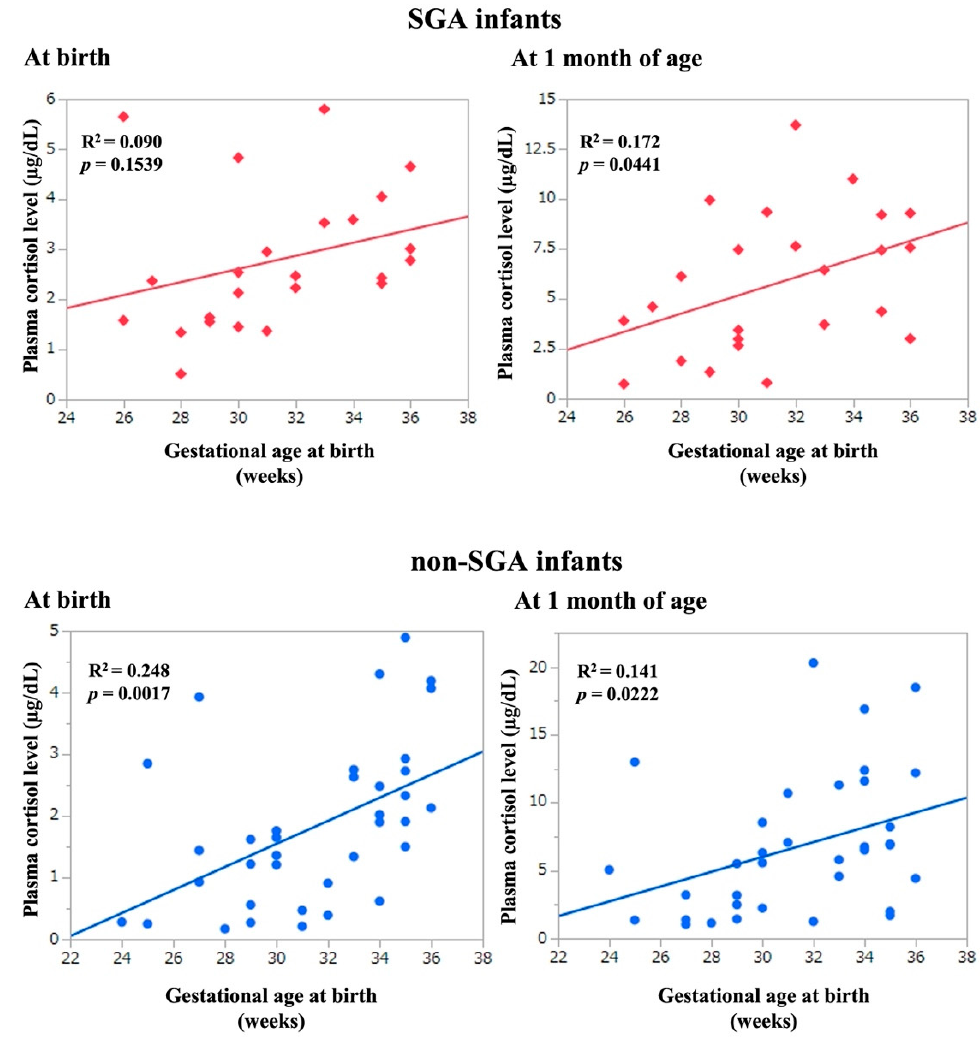
Figure 1. Gestational age at birth and plasma cortisol levels at birth or at 1 month of age. Red rhombus: small-for-gestational age (SGA), Blue circle: non-SGA.